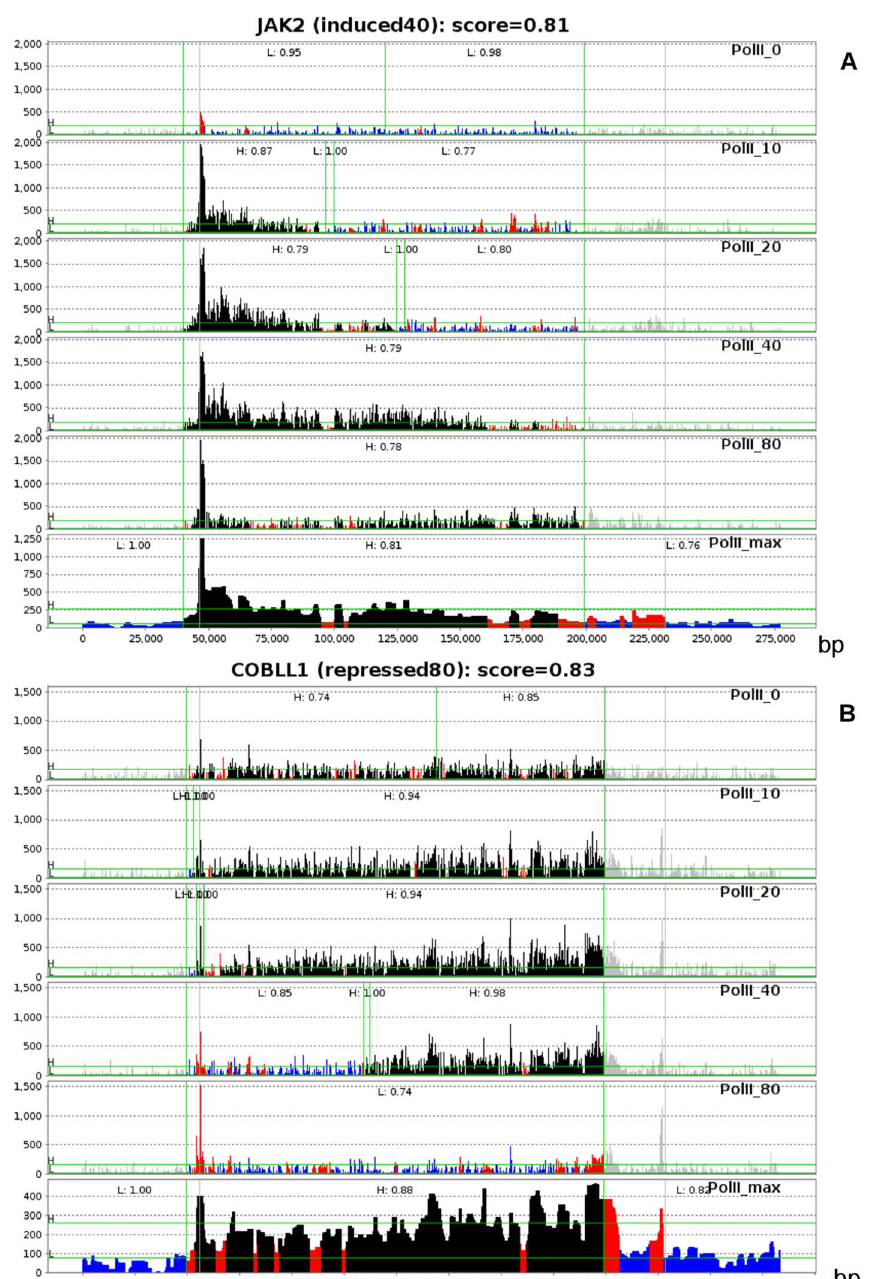
Figure 3. Examples of (A) an estradiol induced gene ( JAK2 ) and (B) a repressed gene ( COBLL1 ). PolII read counts are shown vertically. The last pseudo-sample (locator) is an aggregate sample containing the maximum value of all time points used for fine-tuning the gene location. Initial locations (gray vertical lines) are obtained from a previous optimizer run with PolII and histone markers. Gray bins indicate they are within ignored area (class N ). (A) JAK2 shows a leading edge that progresses gradually and reaches the end of the gene by 40–80 minutes. Transcriptional response starts fading at 80 minutes. (B) COBLL1 shows a similar lagging edge that reaches the end of the gene by 80 minutes.